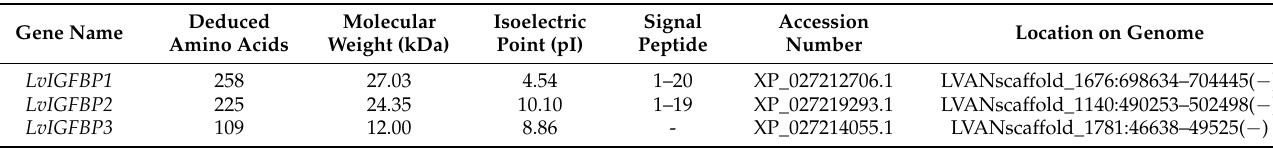
Table 1. Characteristics of LvIGFBP genes and predict amino acid